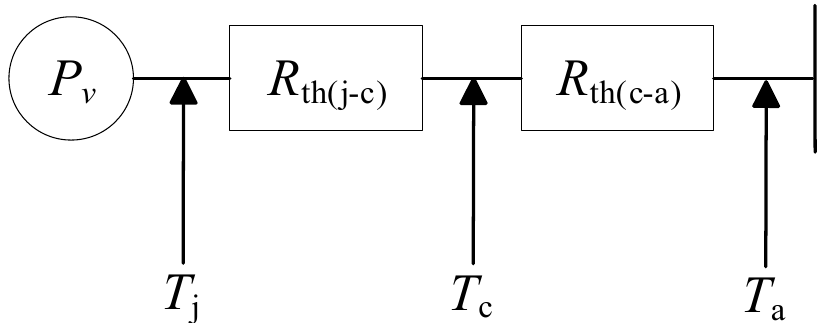
Figure 4. IGBT equivalent computing network for the thermal resistance model.